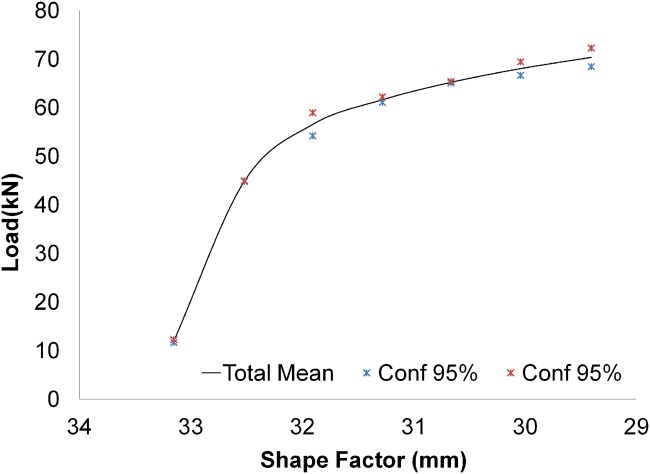
Confidence interval.